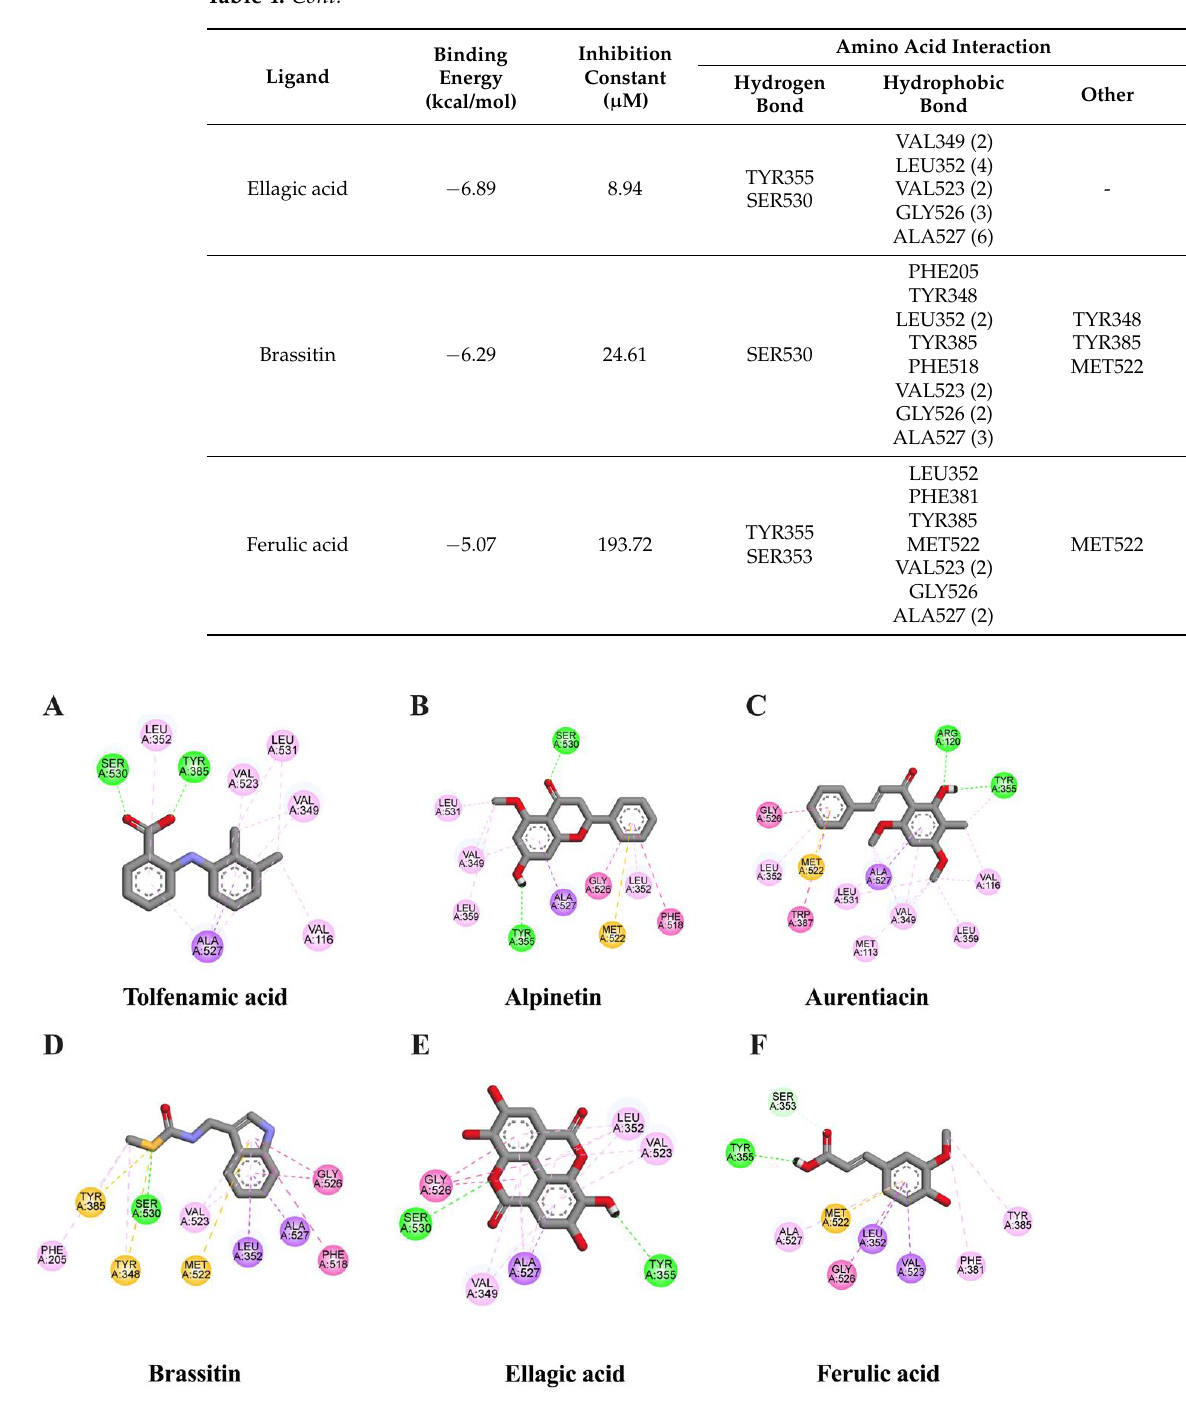
Figure 5. Schematic interactions of amino acid residues between reference inhibitor or candidate compounds and COX-2 protein. The reference inhibitor of COX-2 protein is ( A ) tolfenamic acid and candidate ligands are as follows: ( B ) alpinetin, ( C ) aurentiacin, ( D ) brassitin, ( E ) ellagic acid, and ( F ) ferulic acid. The green dashed line represents hydrogen, the pink or purple dashed lines represent hydrophobic bonds, and the yellow dashed line indicates other bonds.